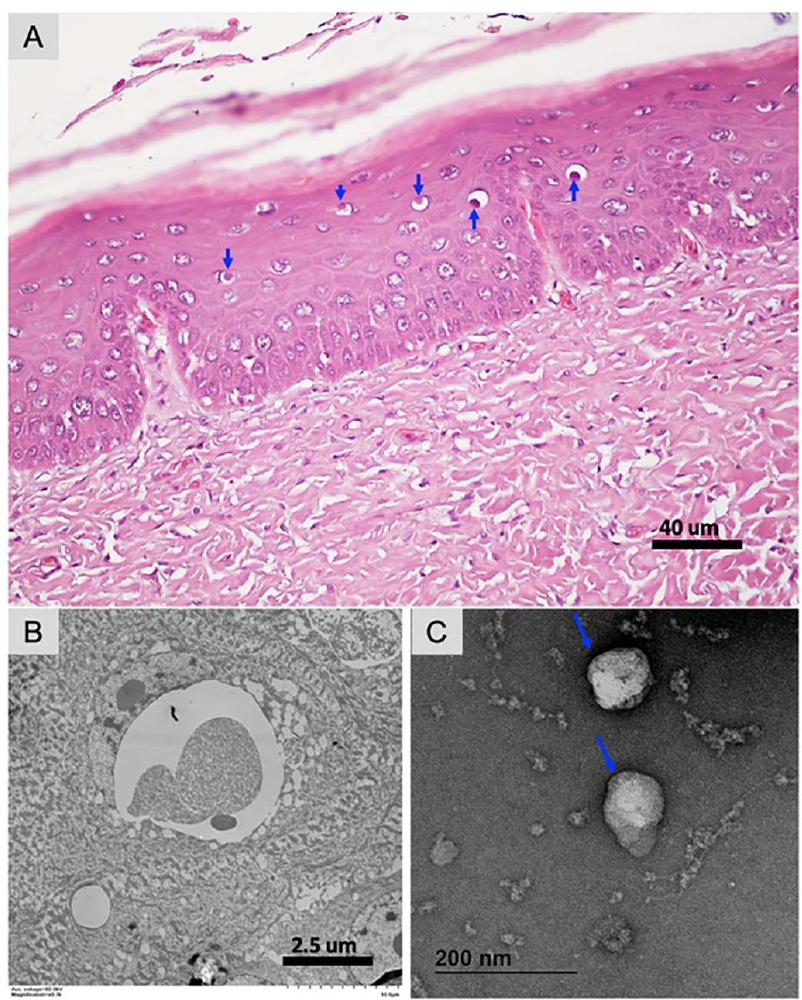
Figure 1. Pathological and transmission electron microscopic analysis of cutaneous tissue collected from a wild green sea turtle. ( A ) Histological changes are characterized by vacuolation and intra- cytoplasmic eosinophilic inclusions in cells in the stratum spinosum with frequent displacement of the nucleus to the periphery (blue arrows). H&E stain, scale bar = 40 µm. ( B ) Transmission electron microscopy (TEM) on tissue section, no viral particles were discerned in these inclusions, which appeared to be composed of proteinaceous material. Scale bar = 2.5 µm. ( C ) Cheloniid poxvirus particles showing brick-shaped virion with regularly spaced thread-like ridges comprising the exposed surface, measuring approximately 140 nm × 98 nm. Outer envelope of cheloniid poxvirus particles is highlighted with a blue arrow.